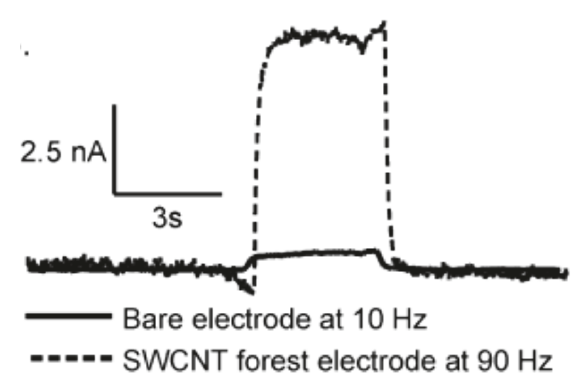
Figure 5: Current versus time trace depicting 40-fold increase in sensitivity after dipping in CNT suspension to form CNT forest electrode [28]. Reprinted from